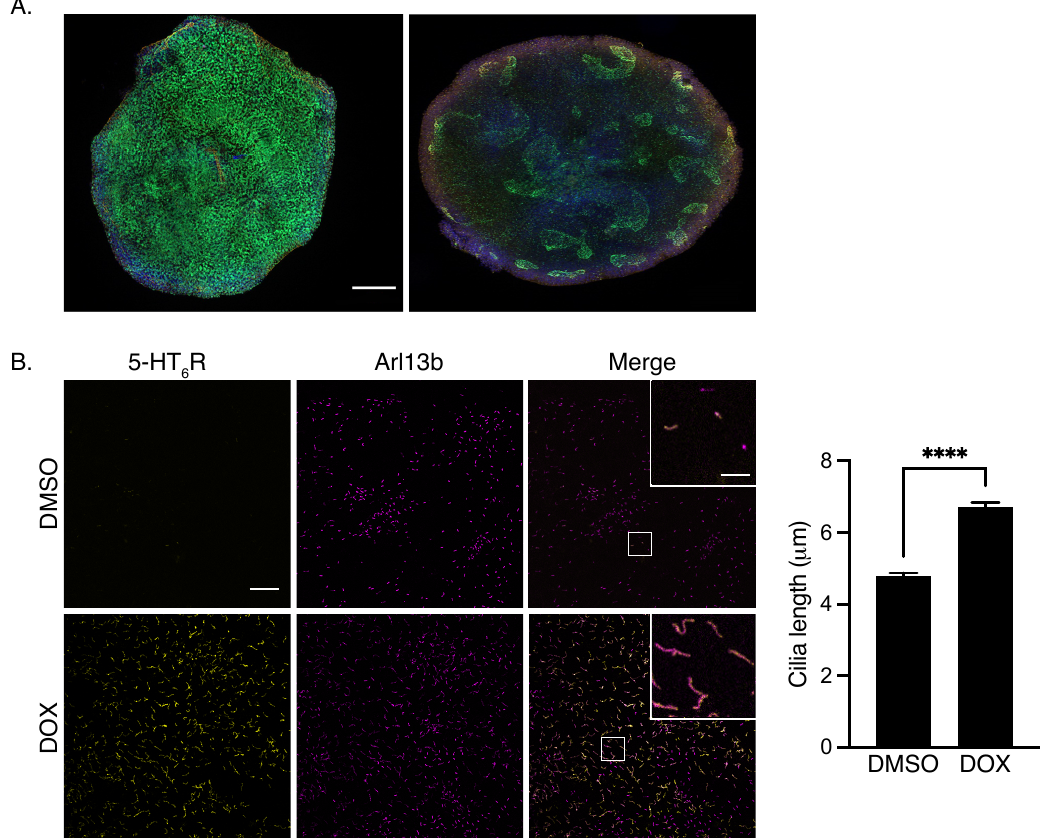
Figure 1. ( A ) Confocal images (20 × ) of 3D cultures (brain organoids) generated from ES cells expressing either cytosolic GFP (left) or 5-HT 6 R-GFP (right). The GFP or 5-HT 6 R are shown in green, nuclei are labeled with DAPI, and primary cilia are labeled with Arl13b (red). Scale bar 200 µ m. ( B ) Confocal images (63 × ) of cells treated with either DMSO (no induction of the 5-HT 6 R expression) or with doxycycline (DOX, induction of the 5-HT 6 R expression) for 24 h, 7 days after starting differentiation. The 5-HT 6 R (yellow) is expressed in primary cilia, as shown by colocalization with the ciliary marker Arl13b (magenta). The inset on the merge image shows a 10 × zoom on cilia labeled with Arl13b and GFP (Scale bar 20 µ m). The histogram on the right shows that cilia length is significantly increased in cells expressing the 5-HT 6 R (DOX) when compared to DMSO-treated cells (6.70 ± 0.13 µ m (n = 558) for DOX-treated cells vs. 4.76 ± 0.09 µ m (n = 460) for DMSO-treated cells). **** p < 0.0001, unpaired t -test. Scale bar 20 µ